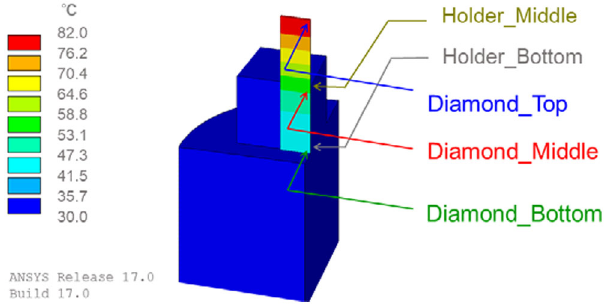
FIG. 9. Quarter model used for the thermal finite element analysis, where the heat sink holder and the cooling base are treated as a monolithic cylinder. The analysis result of a typical case in the normal operation of the SPring-8 standard ID-BLs is shown in a contour